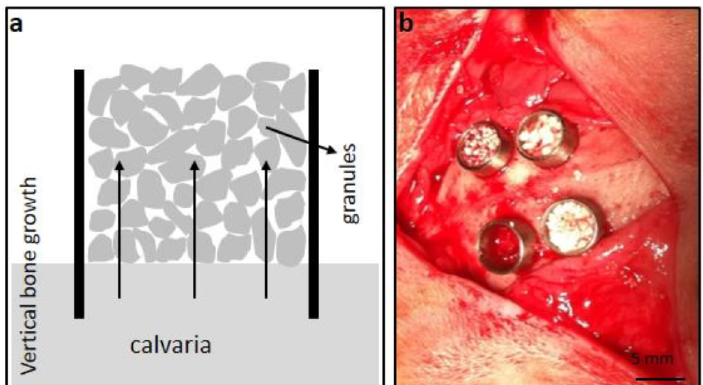
Figure 1. ( a ) schematic representation of vertical bone augmentation model using titanium rings in rabbit calvaria. ( b ) Four titanium rings (4 mm-height and 5 mm-diameter) were implanted in the rabbit calvaria filled with the studied